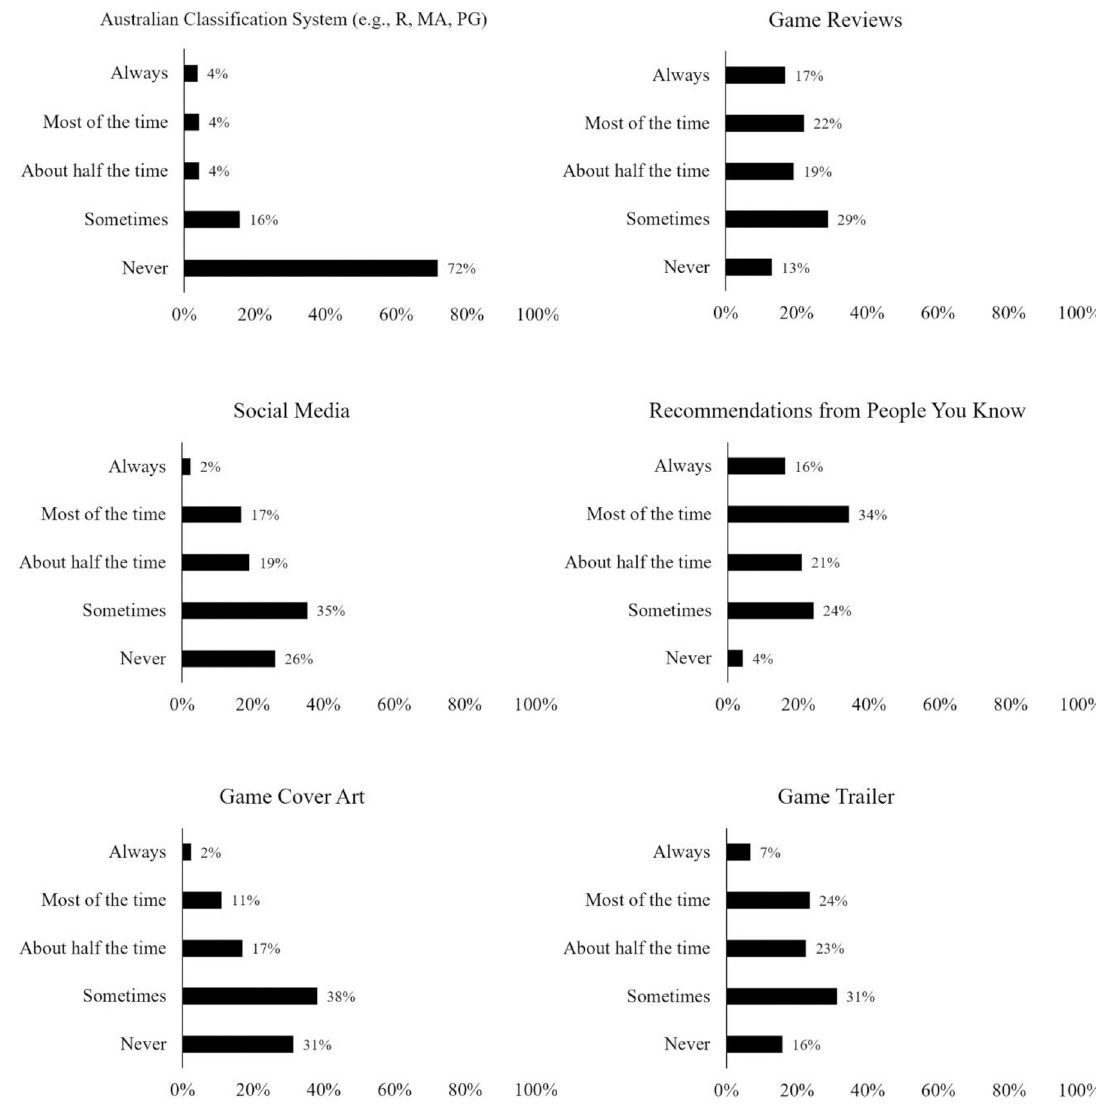
Fig 2. Response distributions for game decision